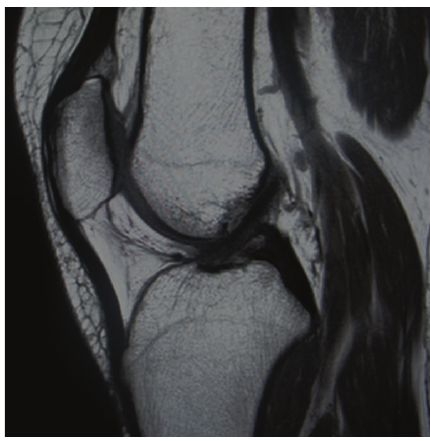
Figure 3: MRI images of patient at final follow-up showing absence of any ganglion